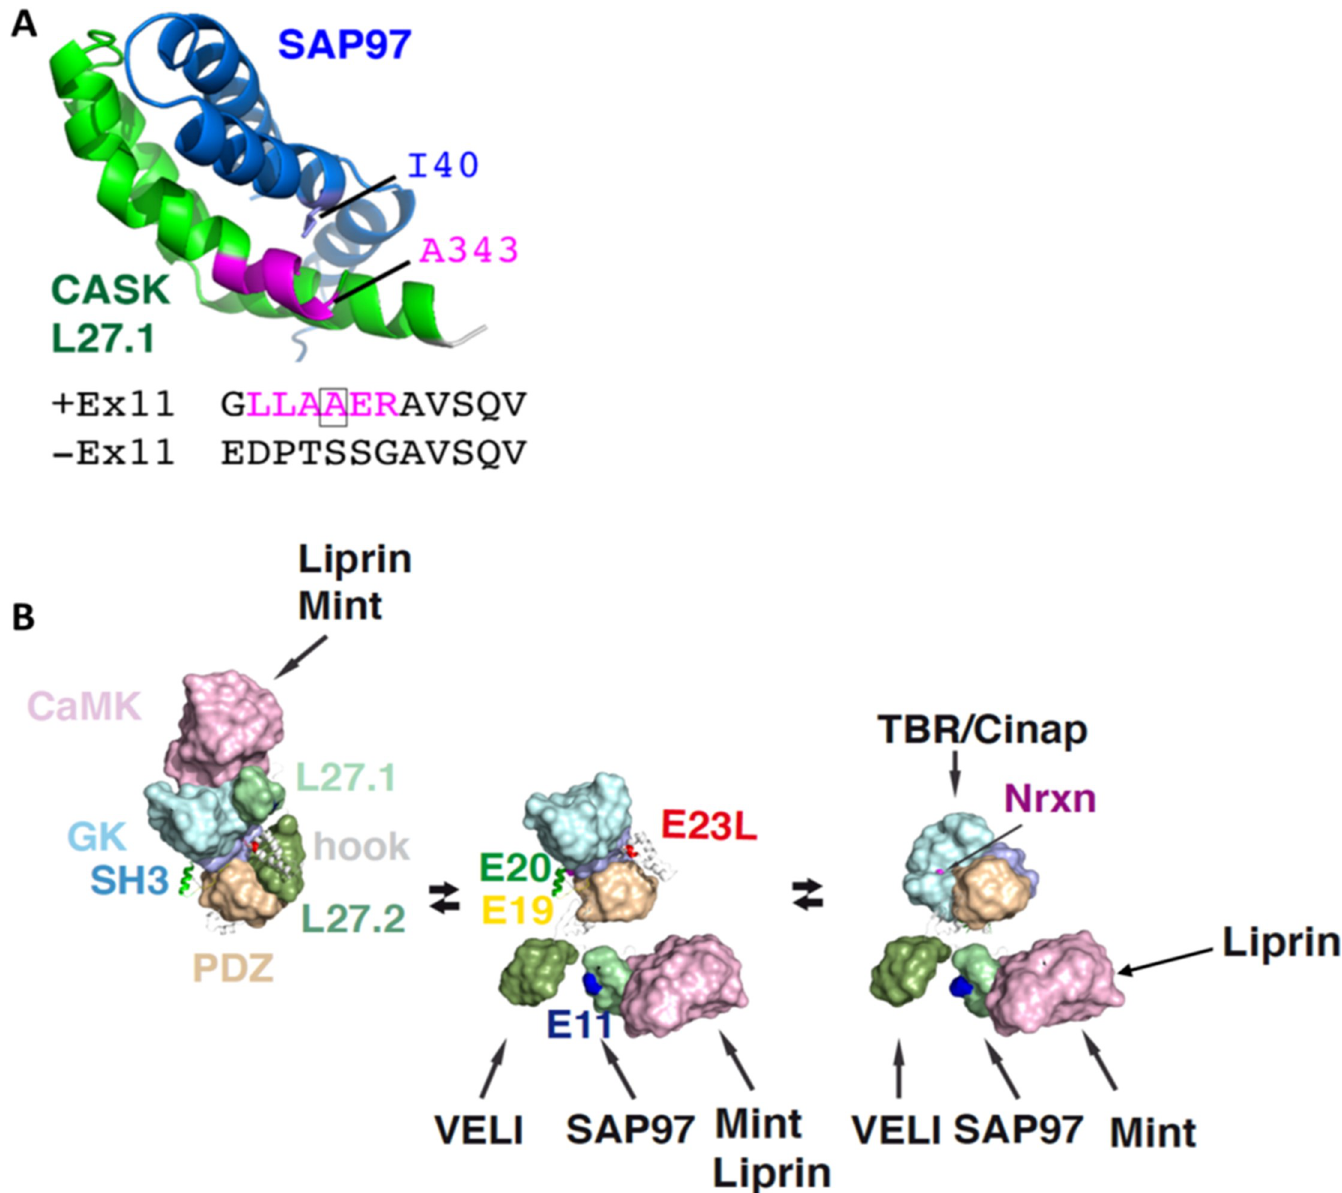
Fig 9. Effect of alternative splice inserts on structural features of CASK. A: Role of the splice insert encoded by exon 11 in the CASK-SAP97 complex. The structure of CASK L27.1 in complex with the single L27 domain of SAP97 contains the additional residues of the splice insert encoded by exon 11 (magenta). The splice insert extents the first helix in L27.1 of CASK, allowing for a hydrophobic interaction of A343 in CASK with I40 of SAP97. A lack of this insert brings highly flexible residues like P, G, T and S to this position, likely giving that helix-turn-helix cluster a higher degree of freedom to stabilize this conformation. B: Possible conformational changes of CASK domains, as suggested by structural analysis of other MAGUKs. A compact conformation (left), where CaMK and L27 domains attach to an extended PDZ-SH3-GK module (PSG) and all splice inserts are buried within the complex would only allow binding to CaMK. An extended PSD-95 like conformation (middle) would allow binding to most CASK binding partners. A PALS-like conformation with an U-formed PSG module (right) is required to bind to TBR/Cinap and the cytosolic C-terminus of Nrxn (middle) would allow binding to most CASK binding partners. Note that Mint and liprin compete for the same binding site in the CaMK domain; however, in the presence of neurexin, liprin binds to an alternative site, allowing for the formation of a tetratrameric complex (Nrxn, CASK, Mint and liprin), as described in ref. [26].